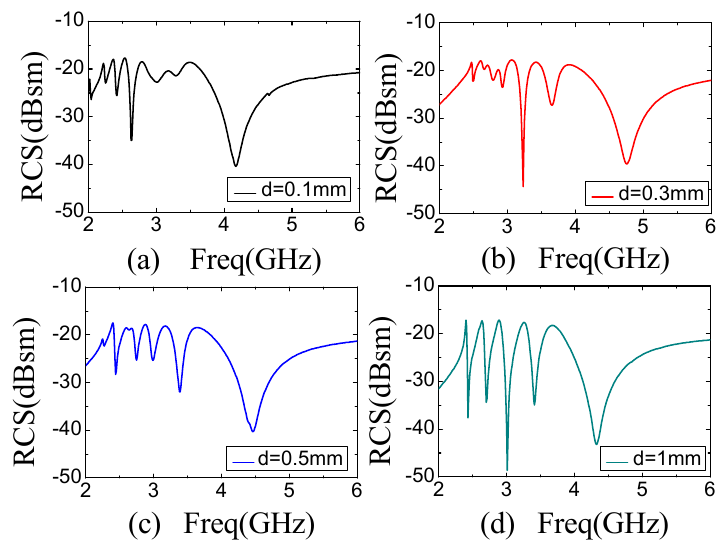
Figure 5. RCS results of five Rectangular Slot Rings with di ff erent d while the slot width is fixed to be 0.5 mm. ( a ) d = 0.1 mm ( b ) d = 0.3 mm ( c ) d = 0.5 mm ( d ) d = 0.9 mm.